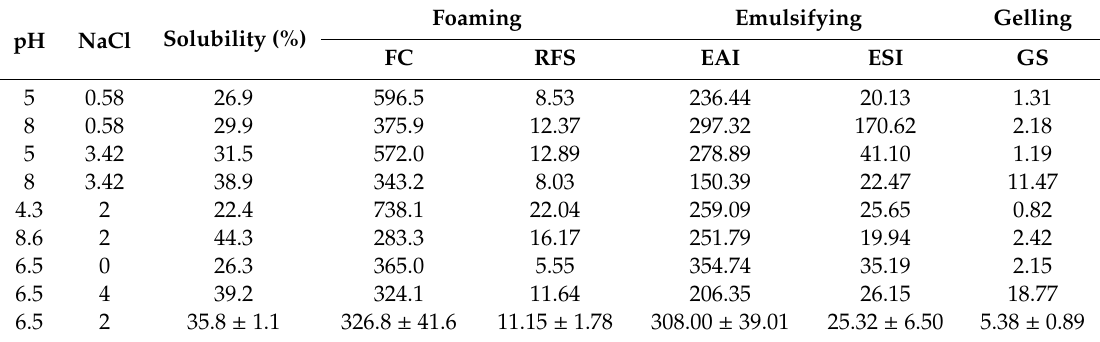
Table 4. Technofunctional properties of soluble protein fractions from porcine heart as influenced by pH and NaCl content (%) of the extraction bu ff er. Foaming Emulsifying Gelling Solubility (%)